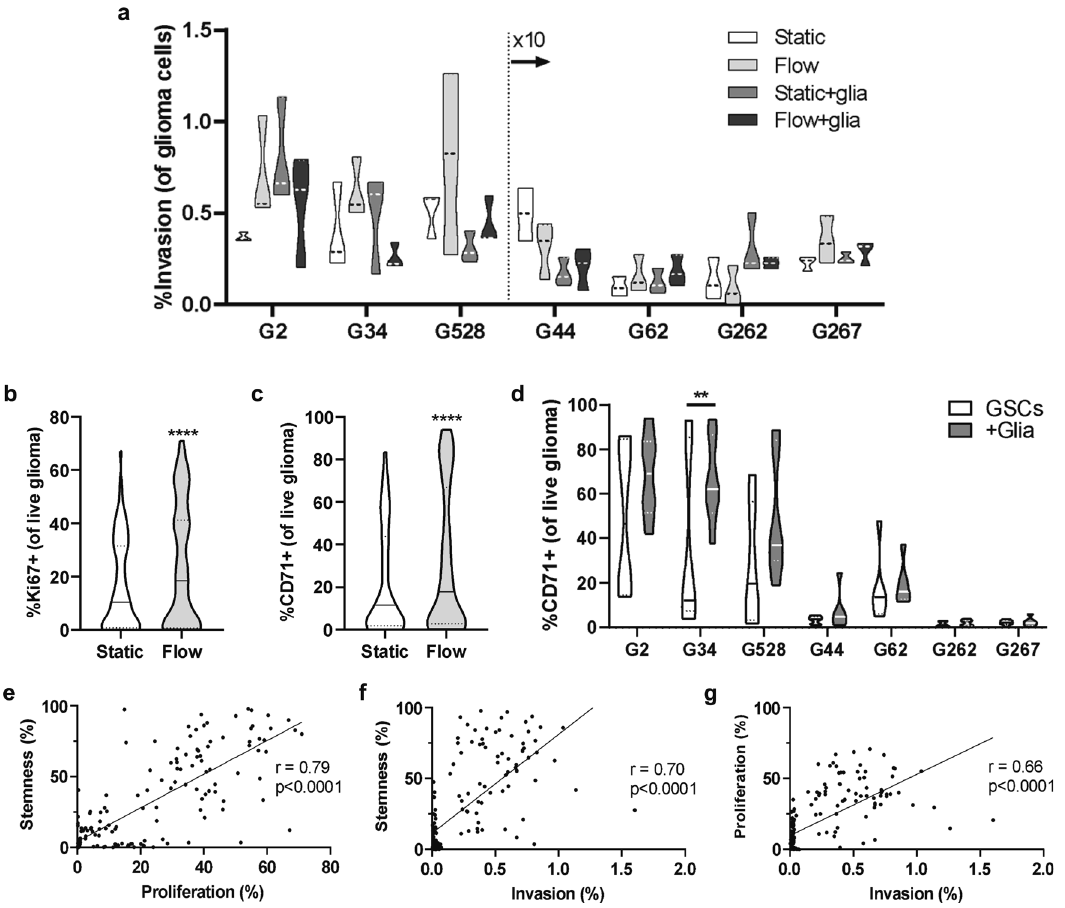
Fig. 3 Interstitial fl ow induces the largest effect on glioma cell proliferation and stemness, and these metrics correlate with invasion. a Invasion data for each cell line in the presence and absence of interstitial fl uid fl ow and/or glia (astrocytes and microglia). Each sample represents n = 3 technical replicates for n = 3 biological replicates. Data for G44, G62, G262, and G267 are multiplied by 10 to enable plotting on the same axis. b Ki67 expression data for all GSCs collected for all conditions ( + astrocytes, microglia, or both) in static (white) vs in fl ow (light gray). c CD71 expression data for all GSCs collected for all conditions ( + astrocytes, + microglia, or + both) in static (white) vs in fl ow (light gray). d CD71 expression data for each GSC line in static and fl ow when cultured alone (white) and in the presence of the TME (medium gray). Statistics were performed by paired t -tests with * p < 0.05, ** p < 0.01, and **** p < 0.0001. e Correlation plot and linear regression of stemness (CD71 + ) vs. proliferation (Ki67 + ). f Correlation plot and linear regression of stemness (CD71 + ) vs. invasion. g Correlation plot and linear regression of proliferation (Ki67 + ) vs. invasion. The respective Pearson coef fi cients are shown in each plot for e – g Table 1. Quantile regression predictive modeling of covariates in the in vitro TME model. Invasion Proliferation Stemness